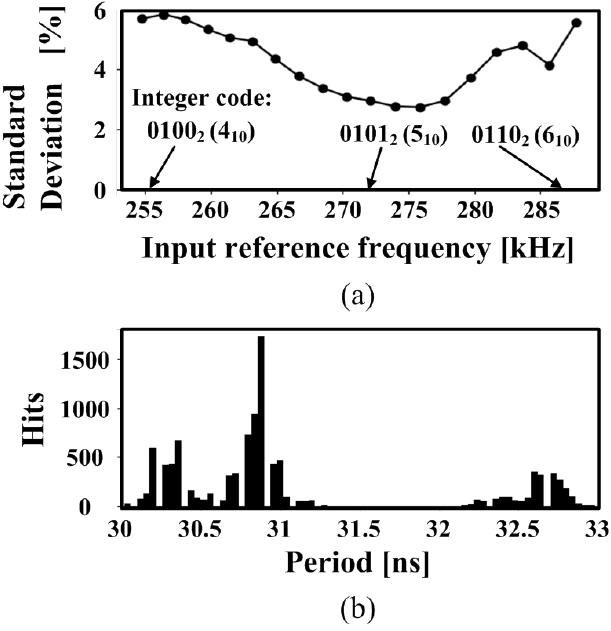
Figure 11. Measured jitter of the divided-by-4 ADPLL output signal: ( a ) standard deviation expressed as percentage of the mean value (10,000 samples), and ( b ) instantaneous period histogram for a input reference frequency of 272